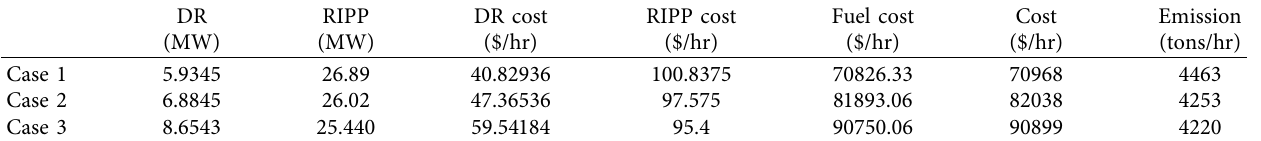
Table 17: Optimized parameters for IEEE 118-bus